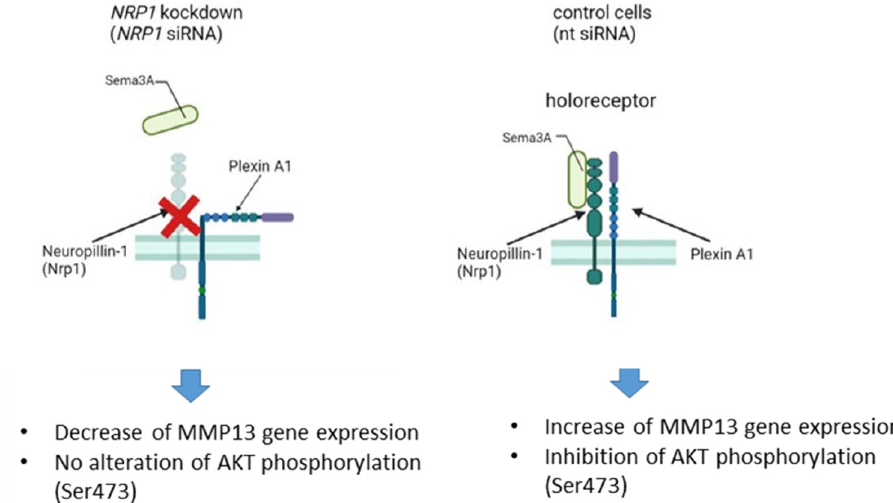
Figure 7. Schematic summary of Sema3A-Nrp1 signaling in OA chondrocytes. Inhibition of Sem3A- Nrp1 binding via NRP1 knockdown leads to a decrease in MMP13 gene expression but no alteration in AKT phosphorylation. Control cells with active Sema3A-Nrp1 signaling axis revealed an increase in MMP13 gene expression together with an impaired AKT phosphorylation.